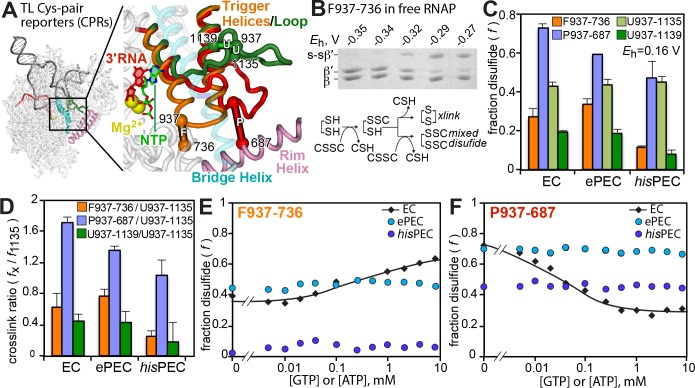
NTP binding but not TL folding is inhibited in the ePEC.Scaffolds used for these experiments are shown in Figure 5—figure supplement 1. (A) Location of F937-736, P937-687, U937-1137, and U937-1139 Cys-pair reporters to test various conformations of the TL. The SI3 domain inserted in the EcoRNAP TL is not shown. A complete description of these reporters is published elsewhere (Nayak et al., 2013; Windgassen et al., 2014). (B) Example CPR reaction showing SDS-PAGE mobility of uncrosslinked and crosslinked β′ as a function of redox potential generated by increasing concentrations of cystamine. Reaction scheme for crosslink generation by cystamine. (C) Fraction crosslink formed by CPRs for the EC, ePEC, and hairpin-stabilized hisPEC in which TL mobility is restricted. Data are mean ± range from two replicates. (D) Ratio of crosslinks to the U1135 crosslink. A high ratio indicates a greater degree of crosslinking (E) F937-736 crosslink as a function of GTP or ATP concentration in 3′dC- or 3′dU-containing EC, ePEC, and hisPEC. (F) P937-687 crosslink as a function of GTP or ATP concentration in 3′dC- or 3′dU-containing EC, ePEC, and hisPEC.